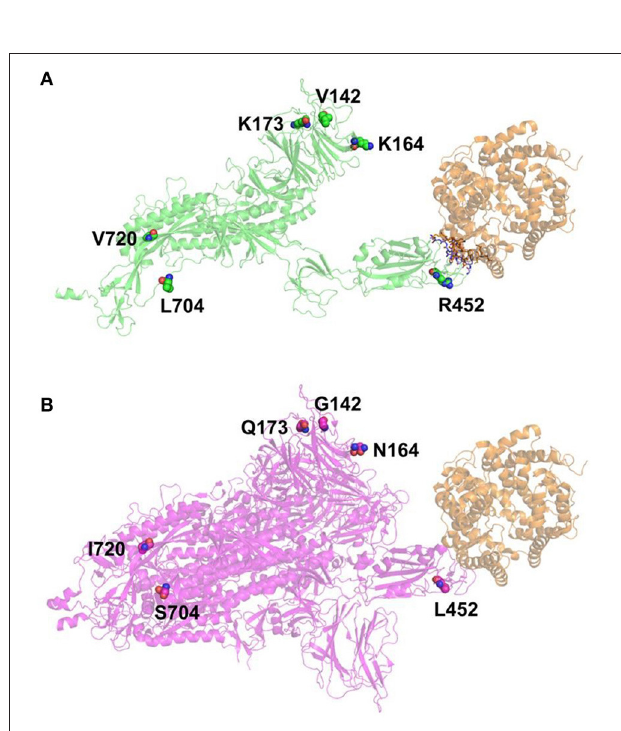
FIGURE 5 | Positions of the mutated residues (presented in spheres, with nitrogen atoms in blue and oxygen atoms in red) in the SARS-CoV-2 Spike proteins. (A) . SARS-CoV-2 P.4 lineage (ribbon in green). (B) . SARS-CoV-2 Wuhan ribbon in magenta as a trimer. ACE2 is presented in orange (ribbon) for both complexes. The figure was generated using PyMol